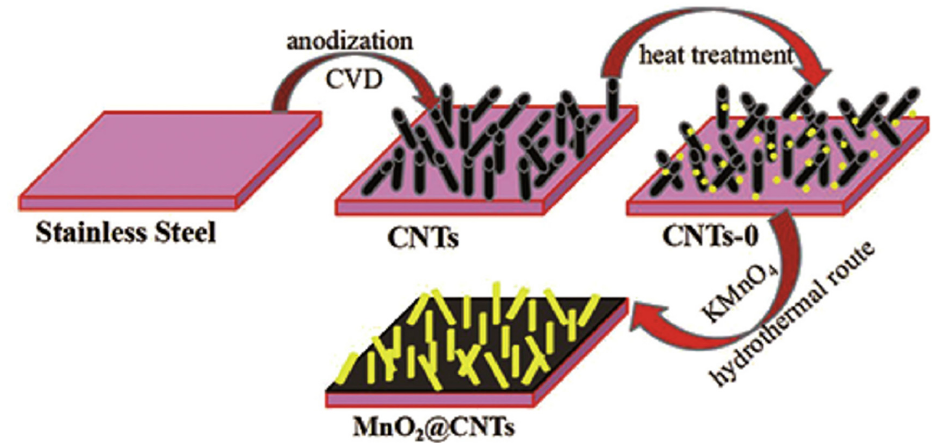
Figure 5. Schematic fabrication of core–shell MnO 2 @CNTs composite electrodes on stainless steel. Reproduced with permission from [119]. Copyright 2020 Elsevier.